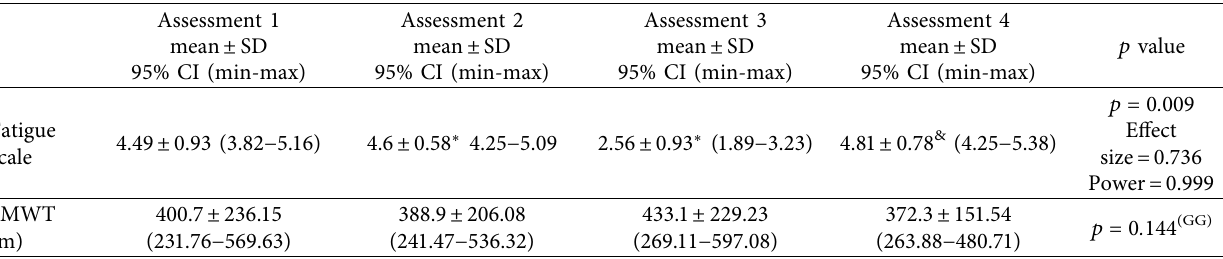
Table 7: Fatigue and 6-minute walk tests per assessment